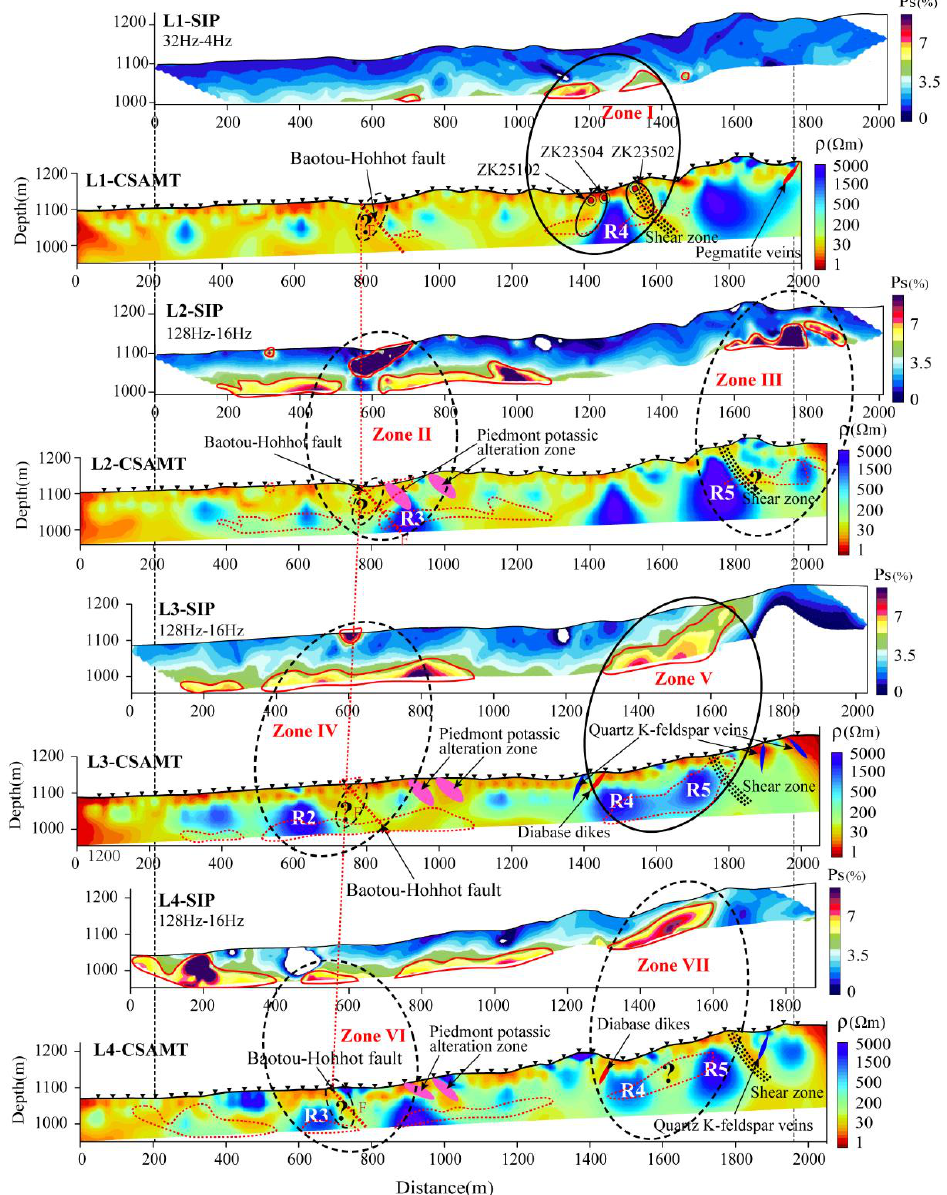
Figure 5. Comparison between the resistivity model and SIP pseudo-section. The profile numbers of the resistivity models and SIP pseudo-sections correspond to each other, as well as the longitudi- nal position of the profiles. Both with topography and the same depth.